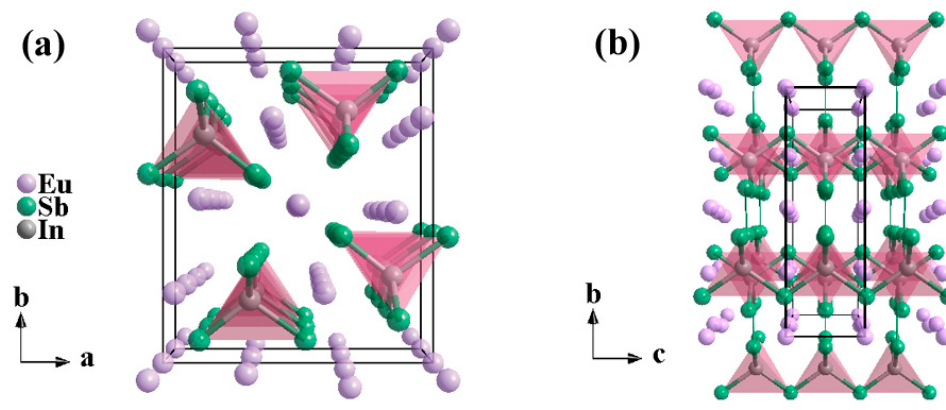
Figure 1. The crystal structure of Eu 5 In 2 Sb 6 viewed along the c axis ( a ) and a axis ( b ).